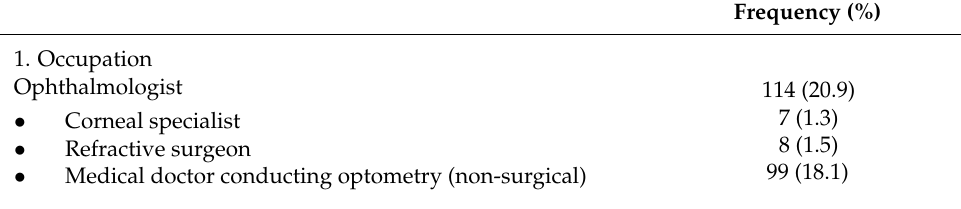
Table 1. Demographics of respondents ( n = 548).